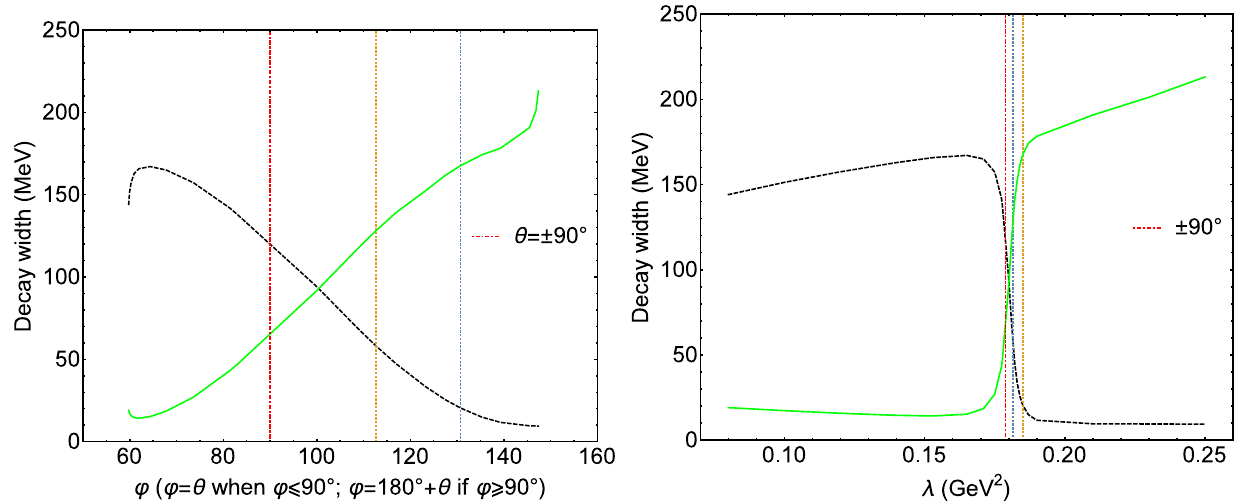
( 2430 ) (green line) decay to D ∗+ π − . Between the blue and orange dotted 1